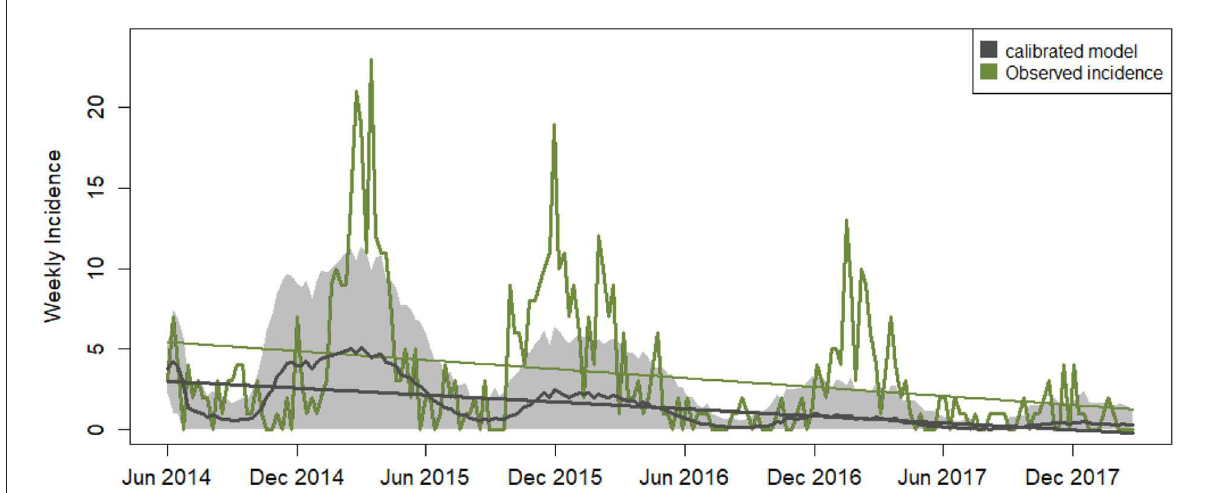
FIGURE3 Weekly time series of disease incidence. Data related to the calibrated model outputs are shown in black: average modeled disease incidence (non-linear black line), its standard deviation generated across 100 iterations (gray shades) and the linear trend with an average slope of − 0.017 ± 0.017. The green line depicts the observed incidence data for North Carolina with a linear trend superimposed of slope −